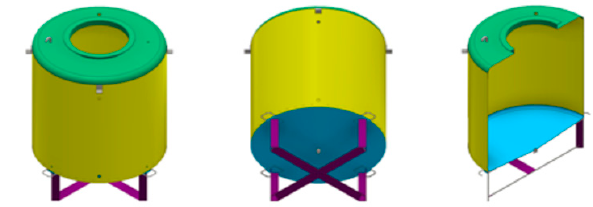
Figure 2. Blueprint of smart collection tank.